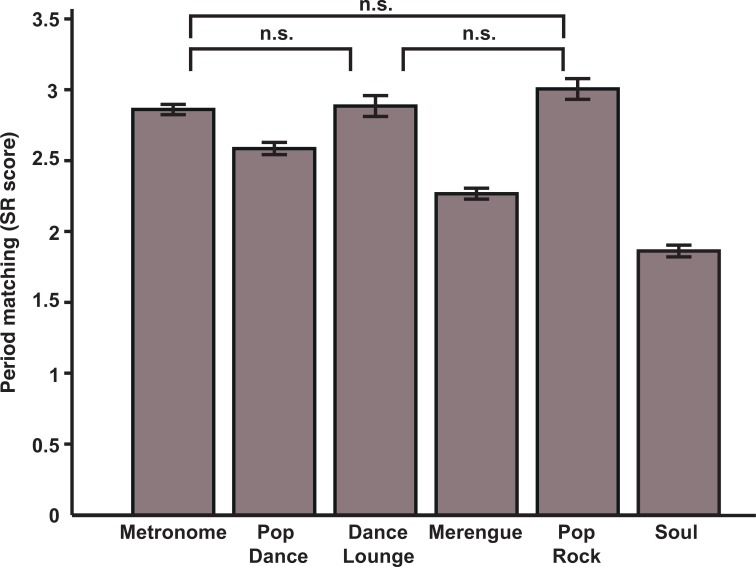
Period matching in Normal Synchronizers' group.Bouncing and clapping scores were averaged for each stimulus and each participant (no interaction between Movement Type and Beat Saliency factors). Error bars represent standard deviations corrected for repeated measures.